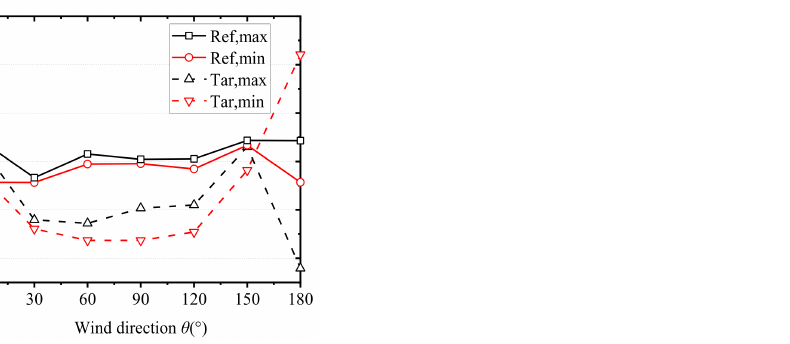
Figure 13. Torsional moments of the target and reference models for different wind